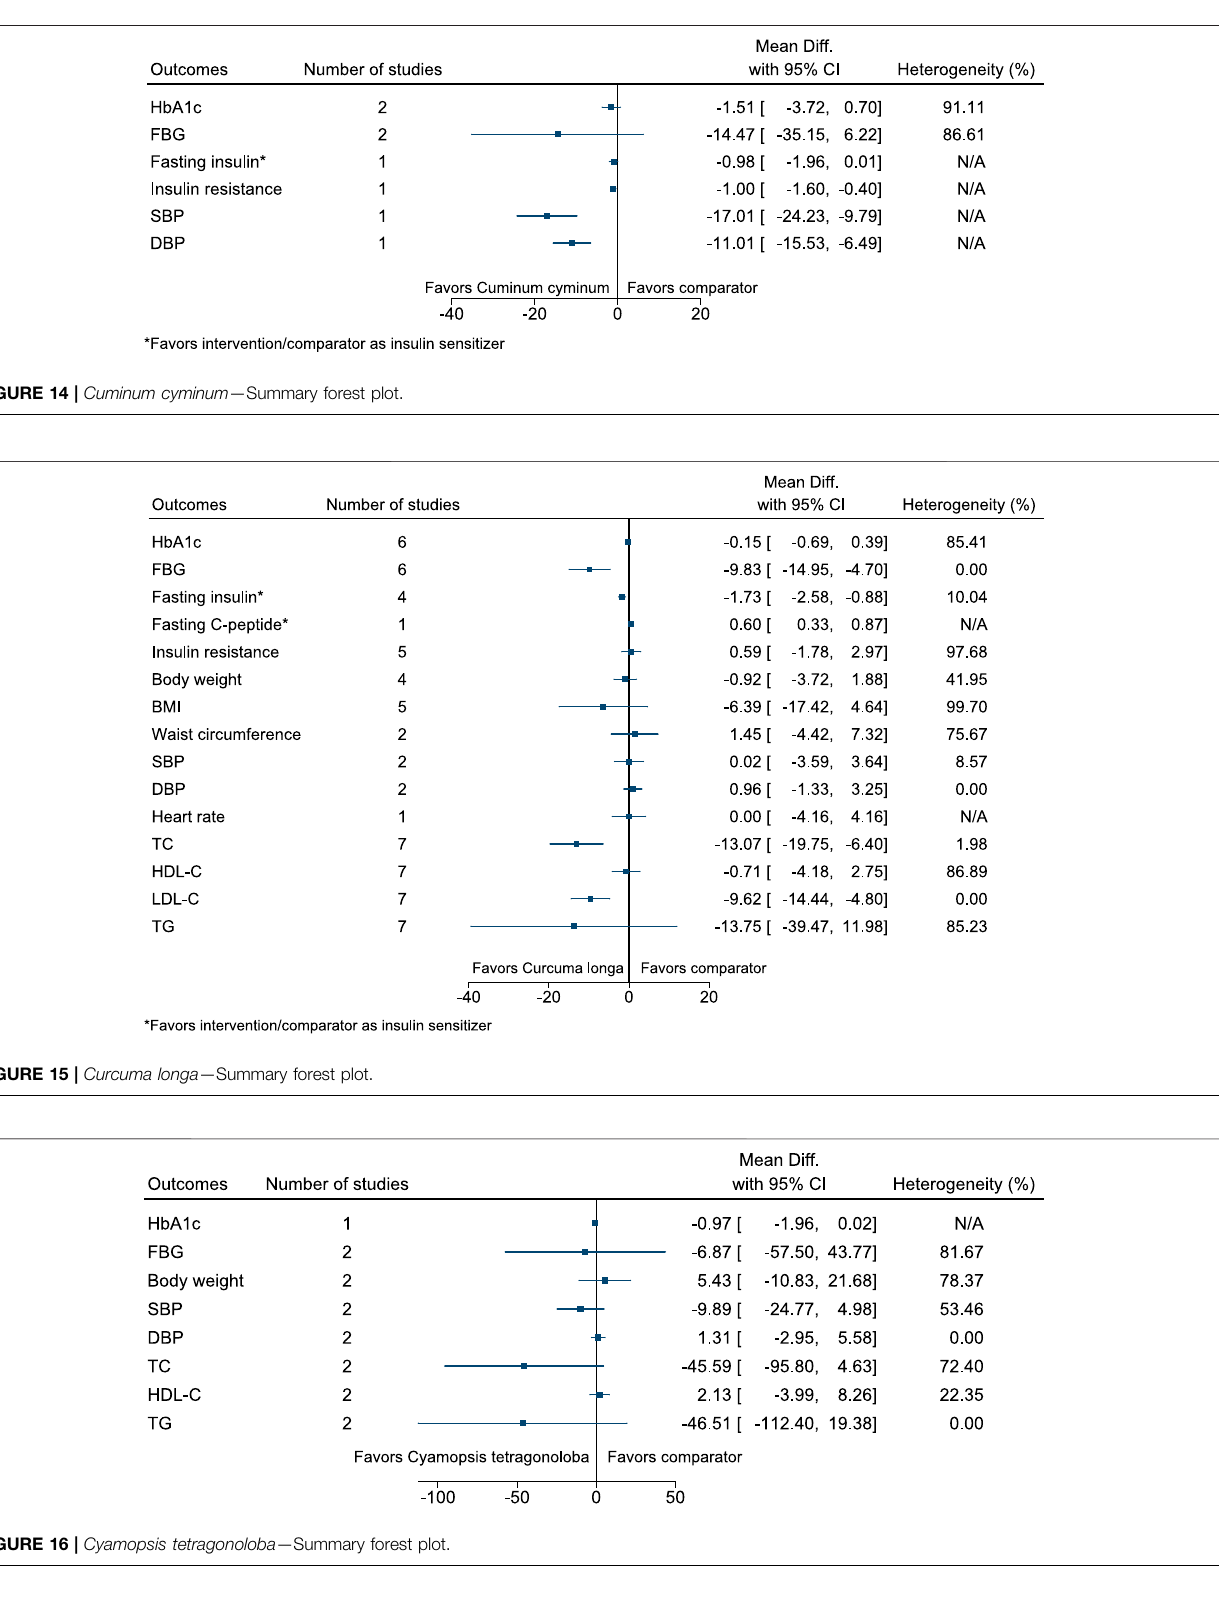
Frontiers in Pharmacology |